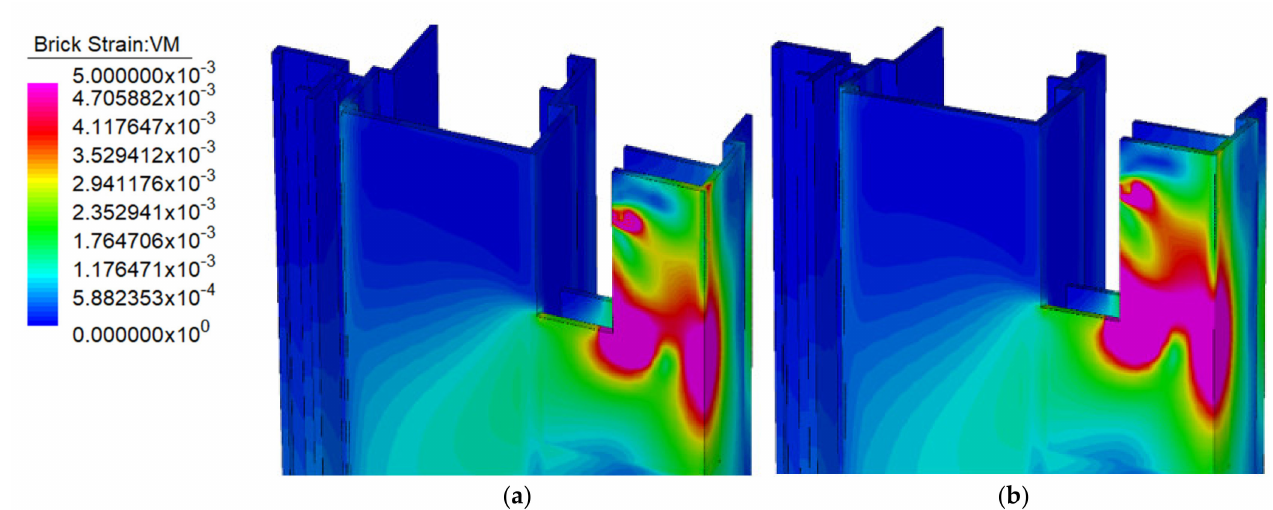
Figure 17. Strain in the model of the sharp notch: ( a ) True stress–strain curve (coupon Al1), load 5.5 kN; ( b ) standardised stress–strain curve (alloy EN AW 6063 T6), load 5.0